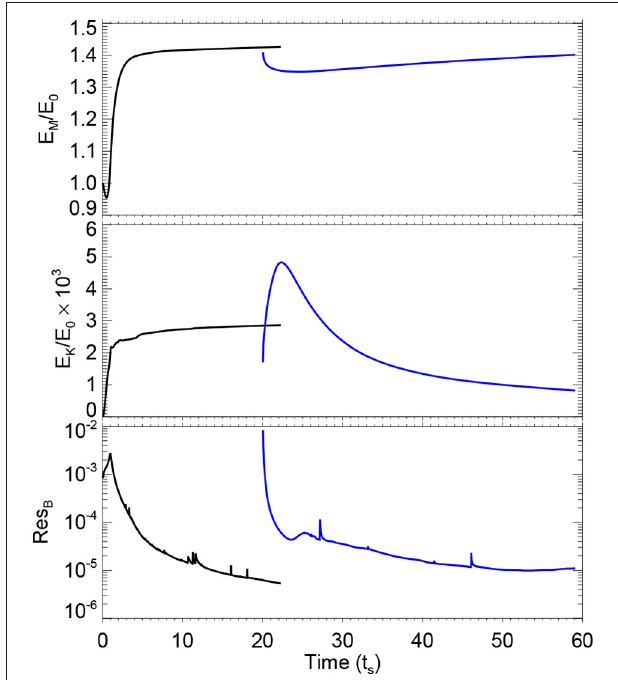
FIGURE 2 | Evolutions of the total magnetic energy, kinetic energy, and residual of magnetic field in the process of the constructing the initial MHD equilibrium. The black curves show the results for the first evolution phase, and the blue ones show that for the second, “deeper” evolution phase.